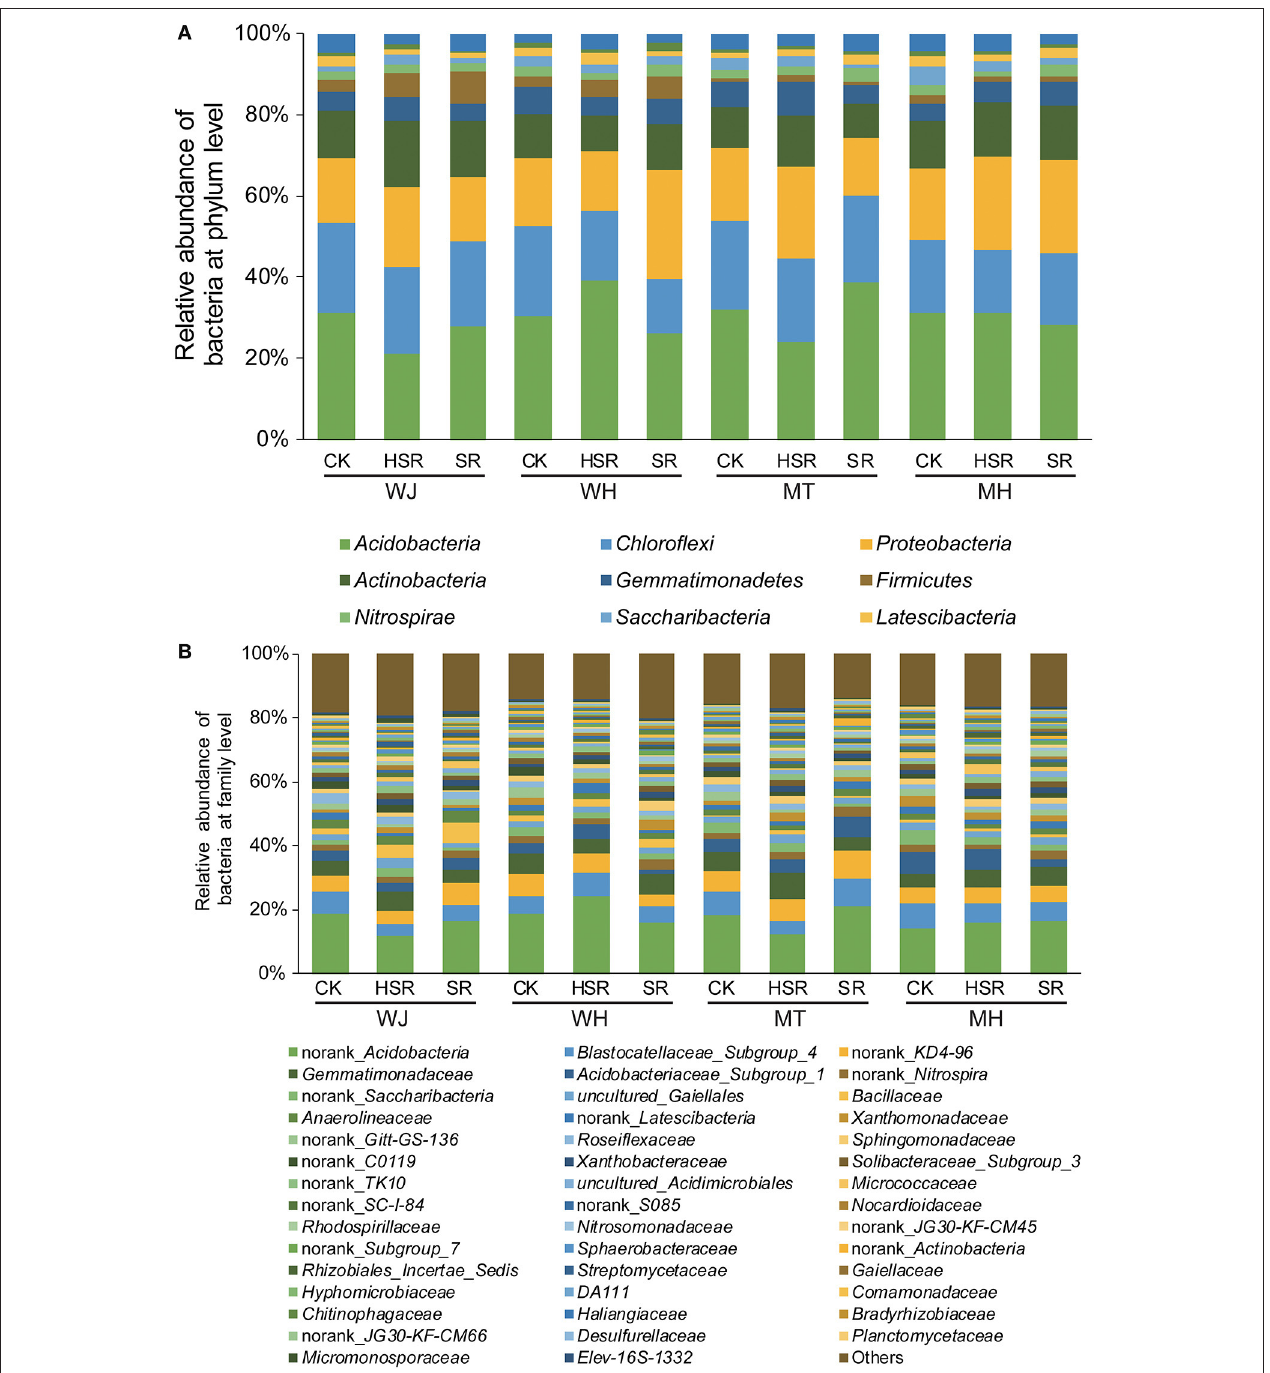
FIGURE 3 | Effect of different amounts of corn straw returned to the field on phylum and family level of bacterial species. J, the jointing stage of the wheat season; H, the harvesting stage of the wheat season; T, the tasseling stage of the corn season; M, the maturity stage of the corn season; SR, all winter wheat straw and all summer maize stalks were pulverized mechanically and returned to the field; HSR, all winter wheat straw and one-half of the summer maize stalks were pulverized mechanically and returned to the field; CK, all winter wheat straw was pulverized mechanically and returned to the field, whereas all summer maize stalks were completely